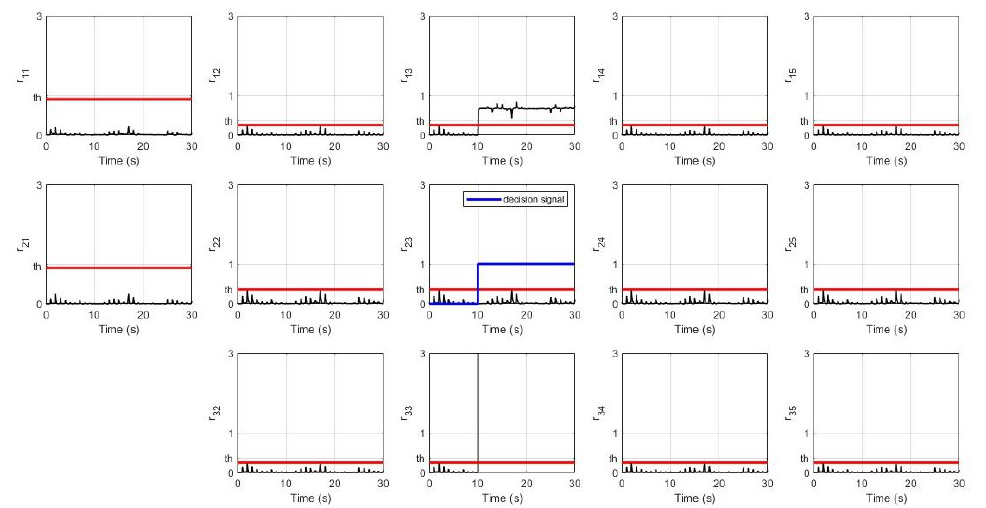
Figure 10. Residual signals with sensor S2 fault in the 3rd robot.